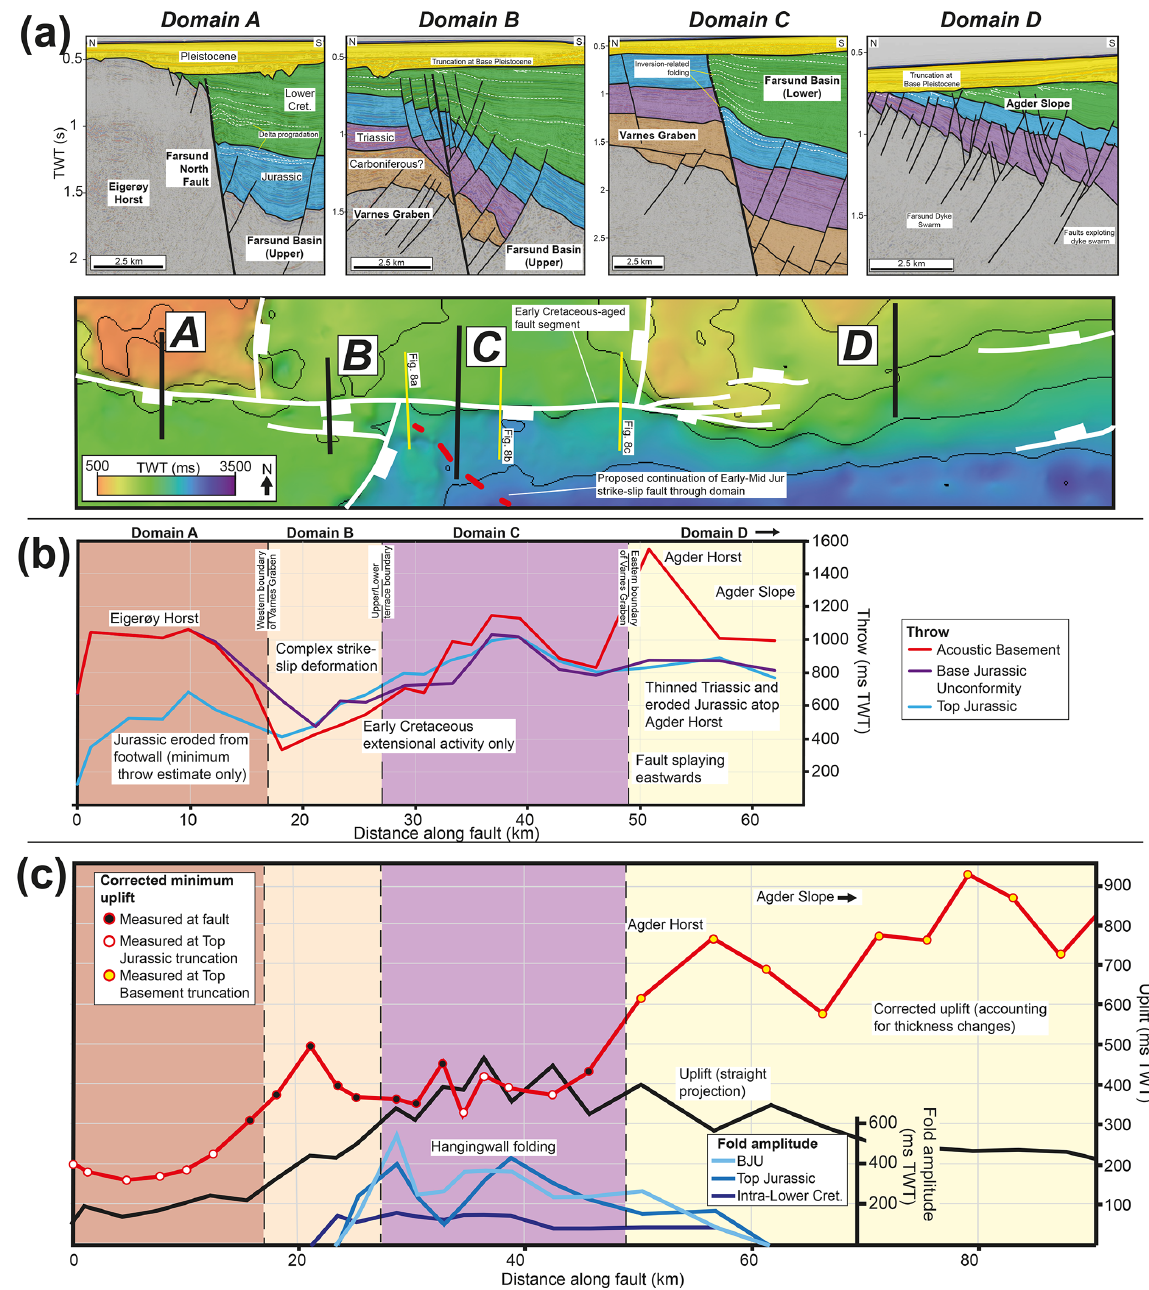
Figure 5. (a) Two-way-time structure map of the acoustic basement horizon and seismic sections highlighting the characteristic structural style associated with each fault domain (a–d) . Black lines show the location of individual domain sections, and the dashed red line indicates the potential continuation of the strike-slip fault in Domain C. (b) Throw-length profiles calculated across the Farsund North Fault for the acoustic basement, base Jurassic unconformity, and top Jurassic horizons. Background colours correspond to different domains. (c) Calcu- lated uplift values (red and black) calculated along the northern margin of the Farsund Basin through the projections of truncated strata. Blue lines show the amplitudes of the hangingwall inversion folds at various structural